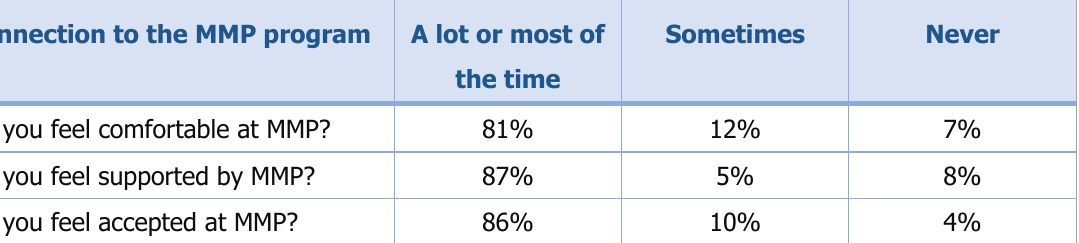
Table 3. Student Responses to Questions Regarding Connection to the MMP Program.